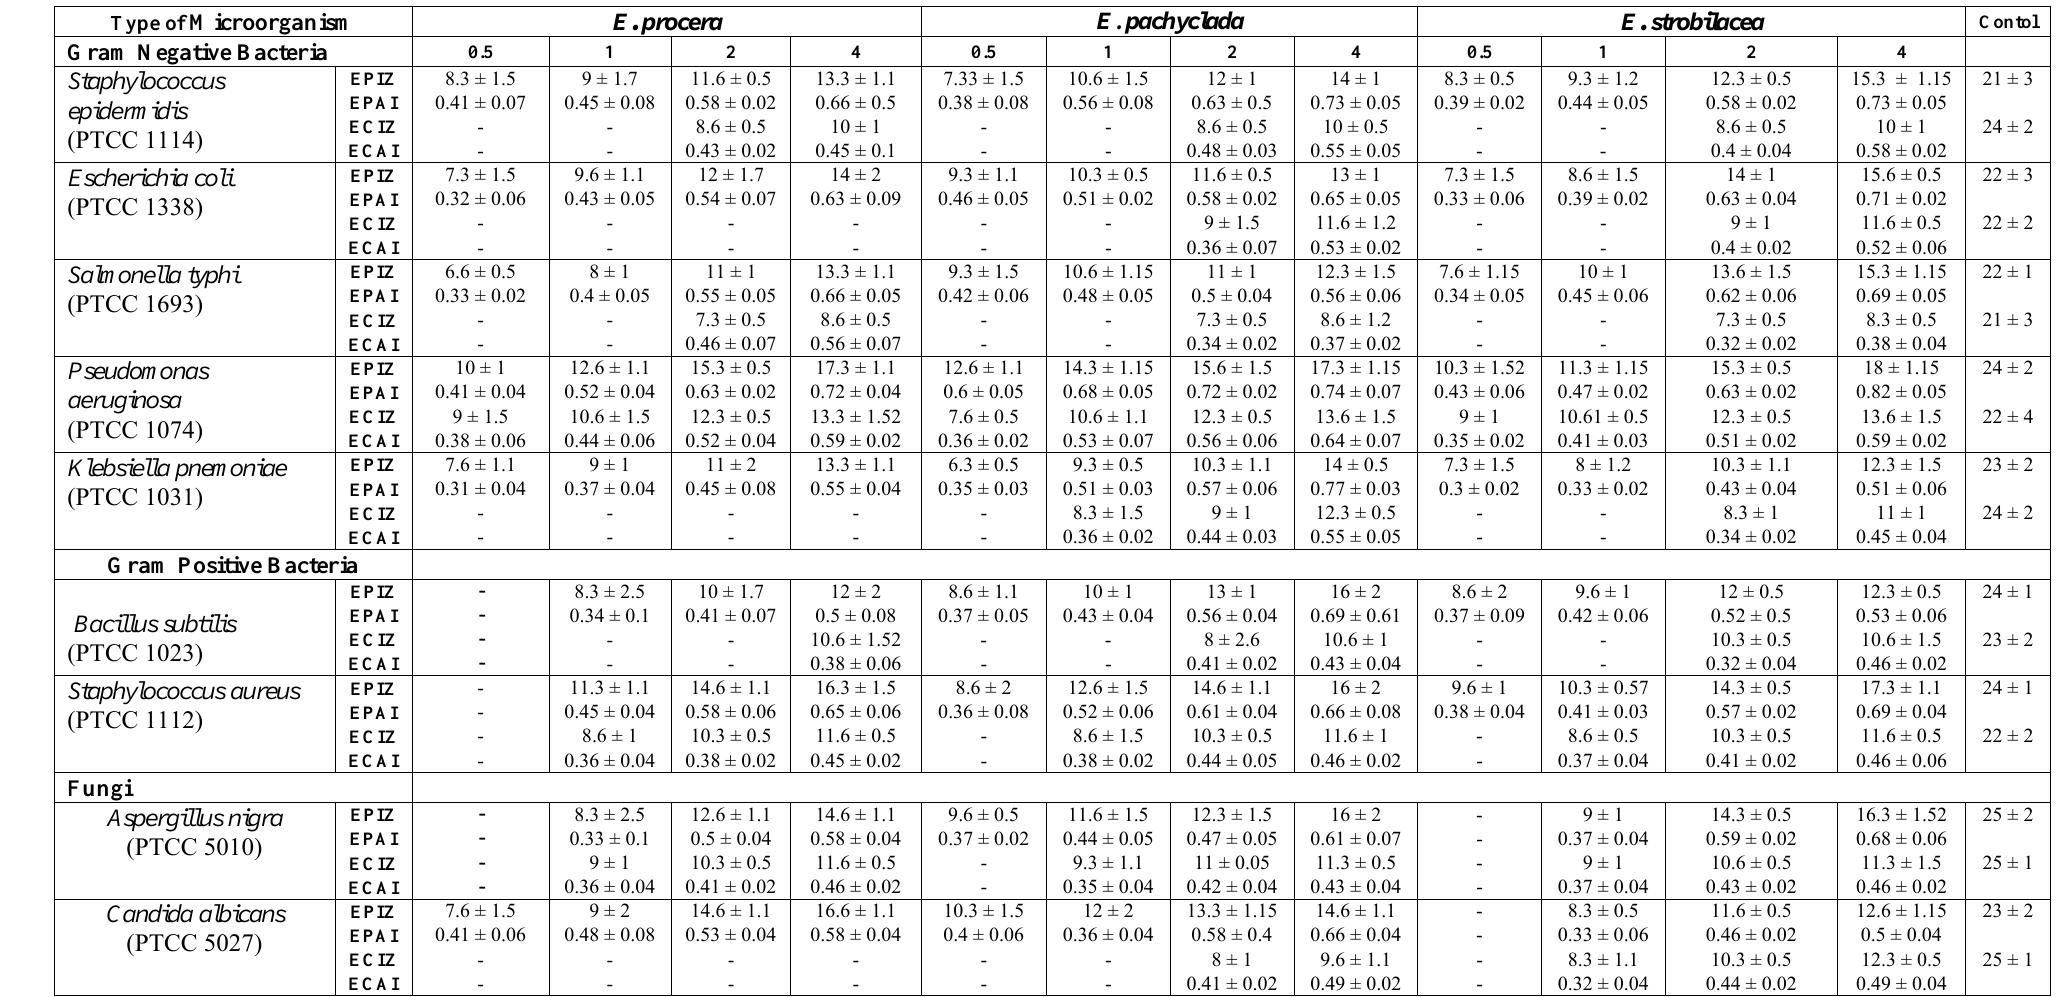
Table 2. Antimicrobial activity of wild plant and callus culture in three species of